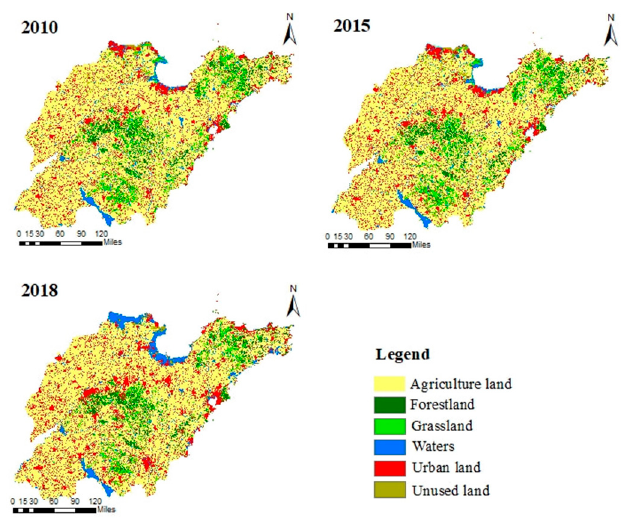
Figure 2. Land use classification of the Shandong province in 2010, 2015, 2018.